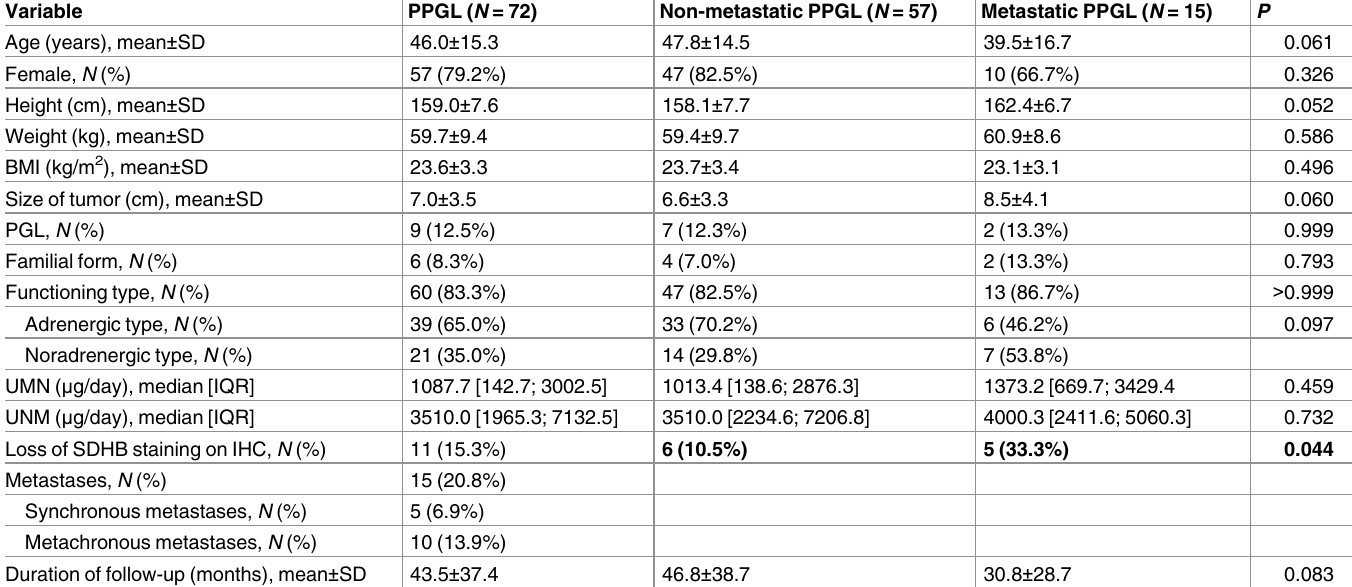
Table 2. Baseline characteristics of the 72 PPGL patients according to the occurrence of